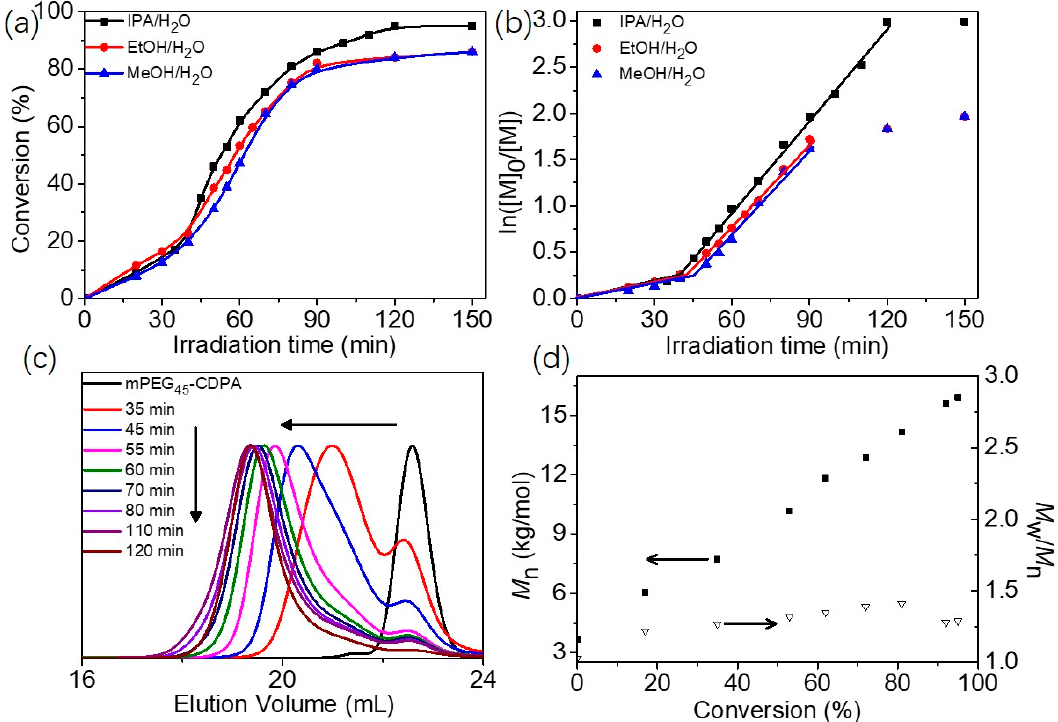
Figure 1. ( a ) Polymerization kinetics for blue light-initiated alcoholic RAFT dispersion polymerization of mPEG 45 -PBzMA 100 with 20% w / w BzMA in different solvents. ( b ) Plots of ln ([M] 0 /[M]) versus irradiation time according to the data in Figure 1a. ( c ) THF GPC traces of mPEG 45 -CDPA and diblock copolymers prepared via blue light-initiated alcoholic RAFT dispersion polymerization of mPEG 45 - PBzMA 100 with 20% w / w BzMA in isopropanol/water (80/20, w / w ). ( d ) Evolution of M n and M w / M n with monomer conversion for the blue light-initiated alcoholic RAFT dispersion polymerization of